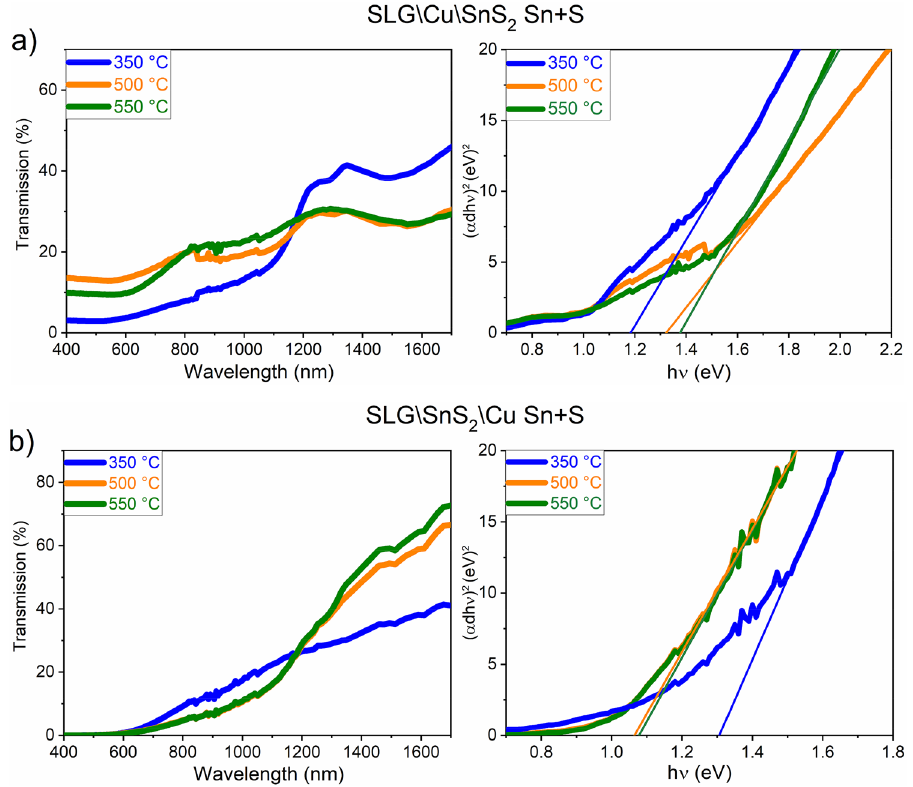
Figure 15. Transmission and Tauc plot of the CTS films annealed under Sn + S atmosphere at different temperatures. ( a ) SLG\Cu\SnS 2 and ( b ) SLG\SnS 2 \Cu